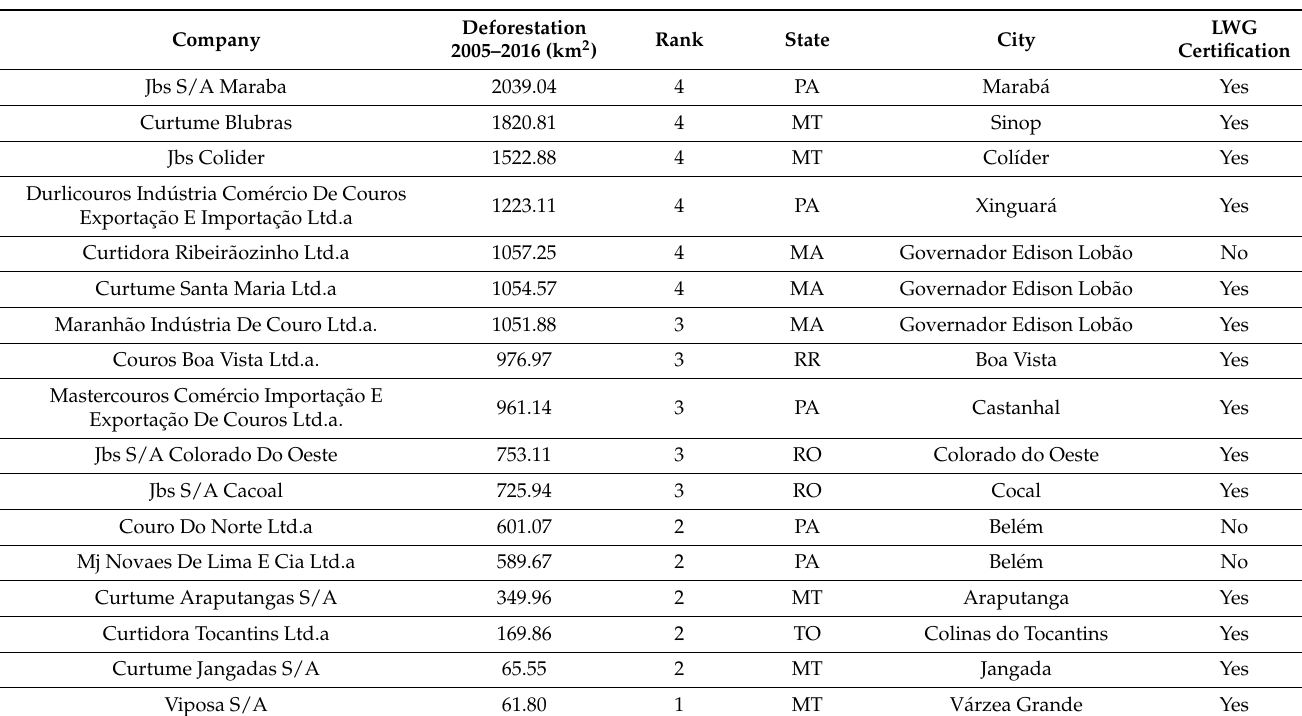
Table A2. List of tanneries in Brazilian Legal Amazon, the assigned deforestation risk and associated information